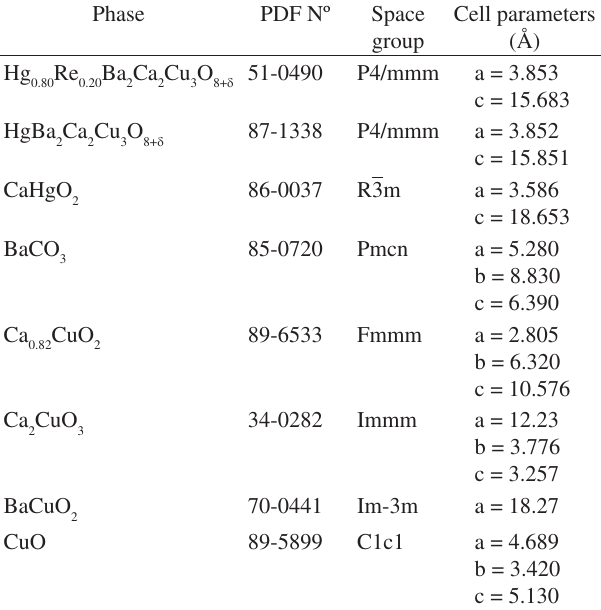
Table 3. Identified phases according to Powder Diffraction File - PDF- ICDD Phase